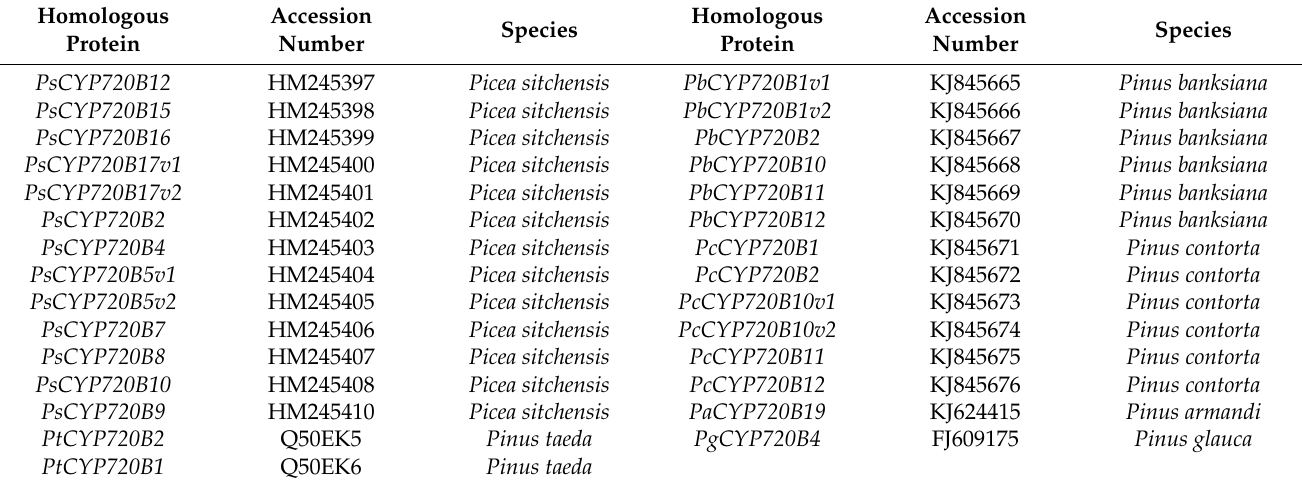
Table A1. Information on 29 homologous proteins.